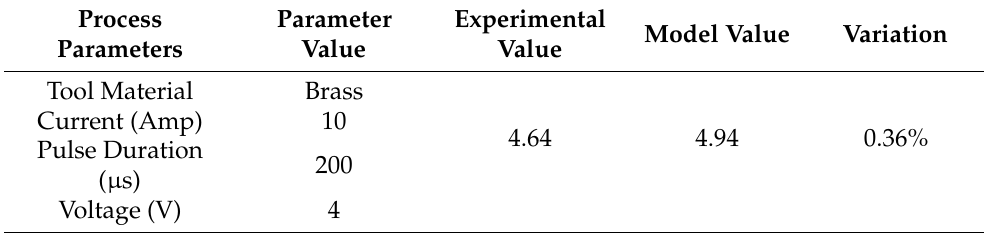
Table 10. Confirmation test for